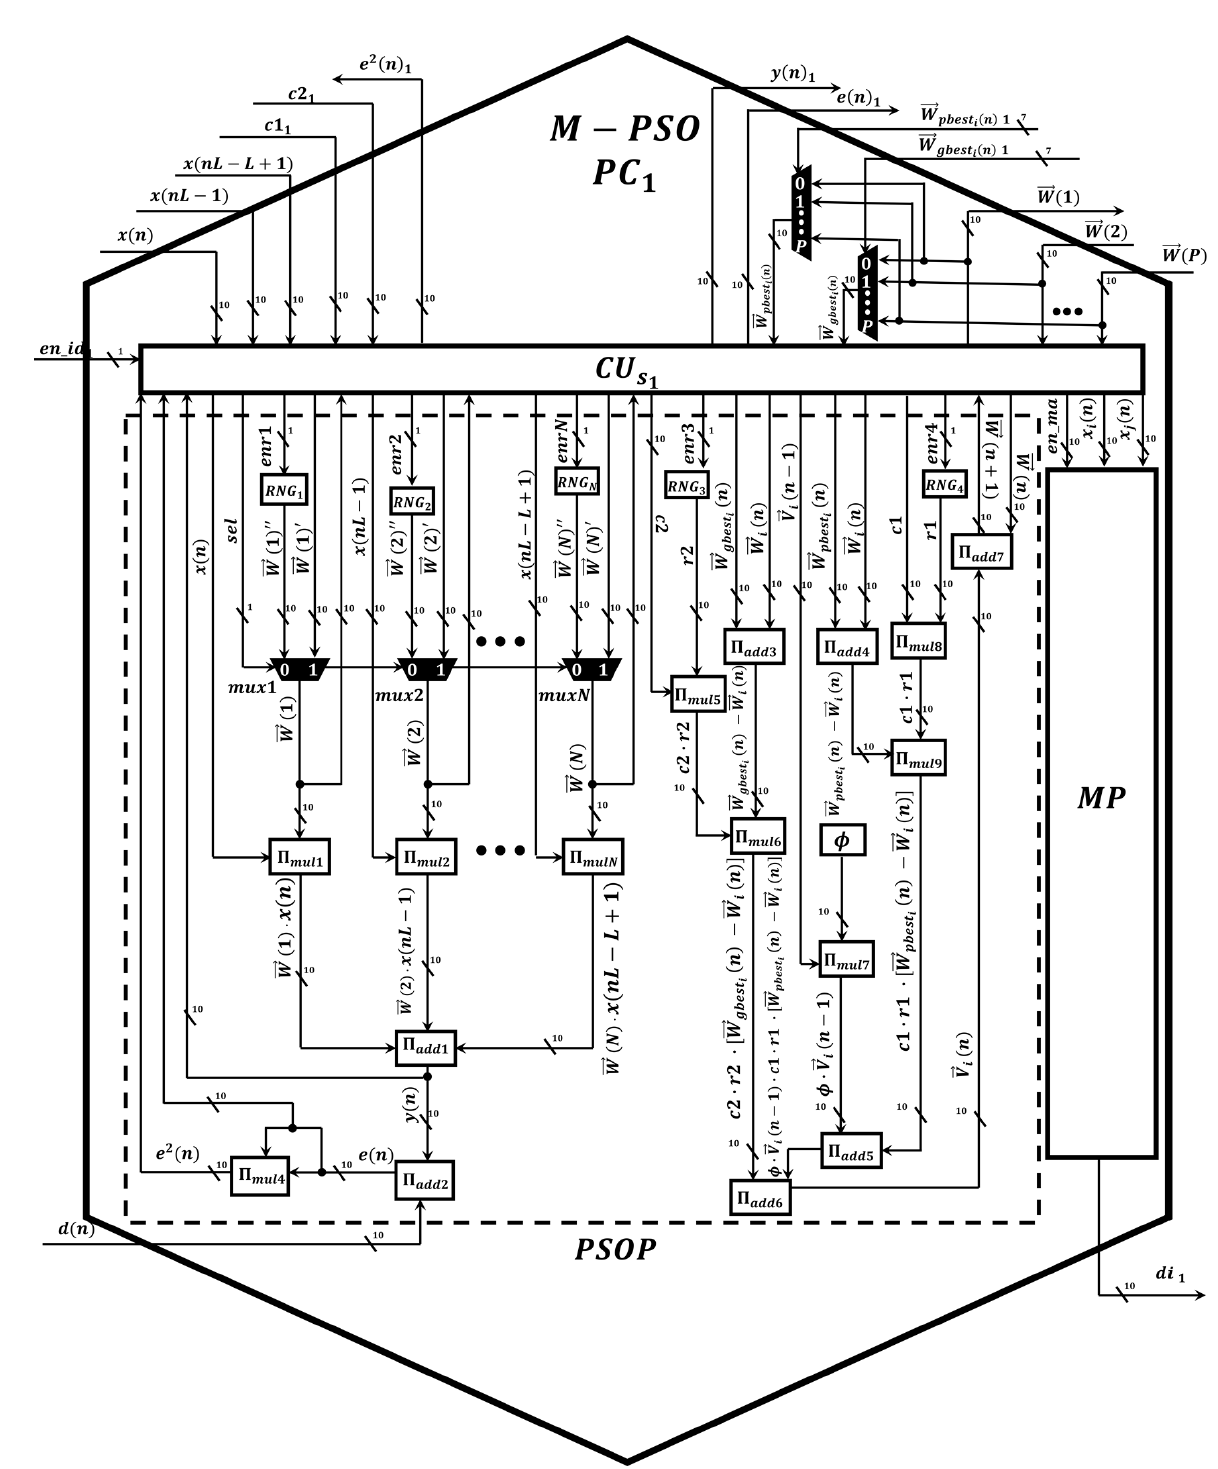
Figure 8. Digital circuit scheme of the Markov-PSO processing